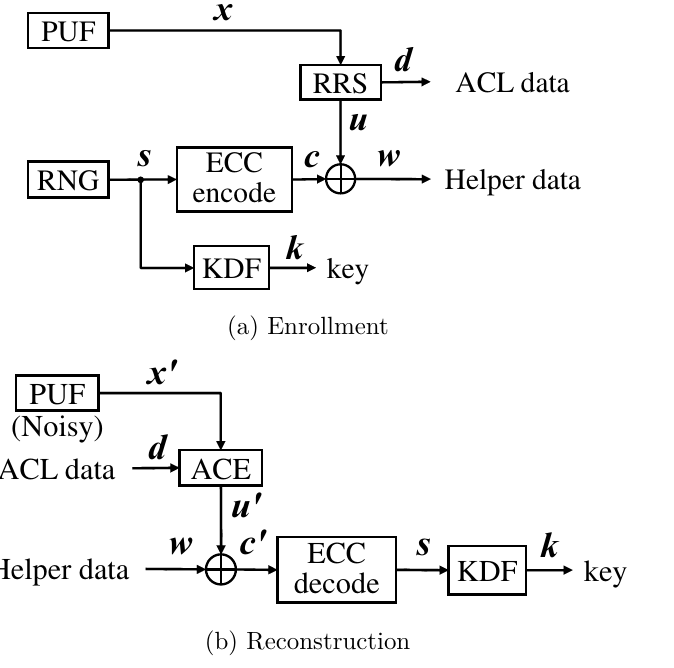
Figure 7: Block diagram of AR-based